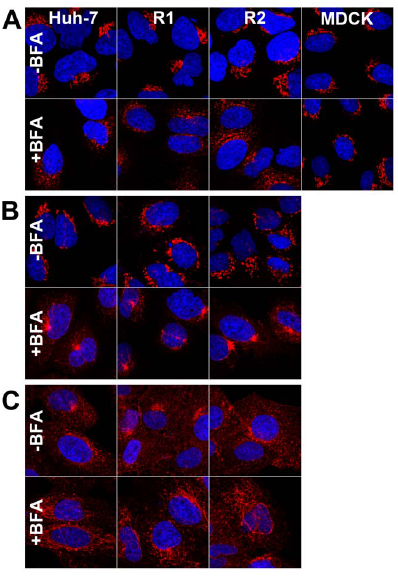
Figure 6. Morphology of BFA-sensitive compartments of R1 and R2 cells. Cells of the indicated cell lines were treated with 2.5 m g/ ml (A) or 5 m g/ml (B, C) BFA for 30 minutes, fixed and processed for the immunofluorescent detection of GM130 (A), TGN46 (B), or the transferrin receptor (C). The nuclei were stained with DAPI. Represen- tative confocal images are presented. Bar, 20 m m.